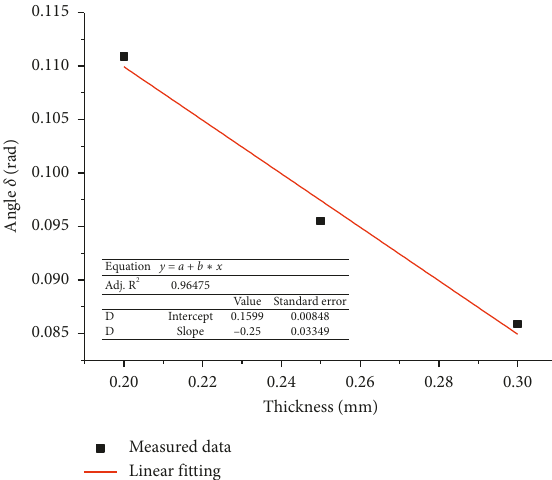
Figure 7: Dependence of the angle δ on the thickness of the